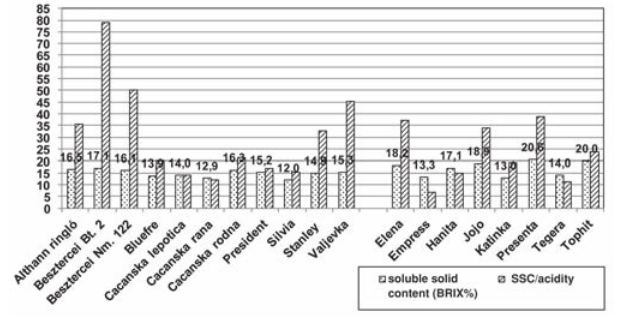
Figure 6. Mean water-soluble solids content and the ratio of soluble solids per titrable acids in plum fruits of